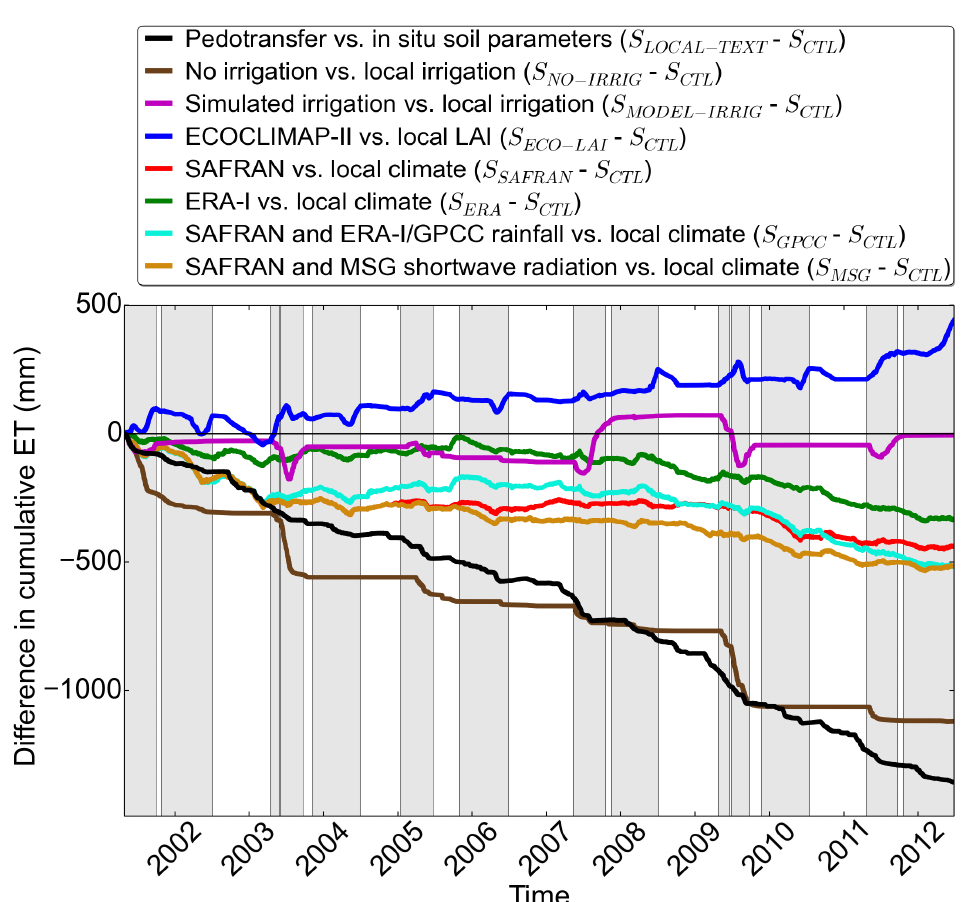
Figure 10. Differences in cumulative ET between each experiment achieved with the large-scale data set and the control run (S CTL ) achieved with the local observations for each tested driver. Crop periods and inter-crop periods are represented by grey and white backgrounds,